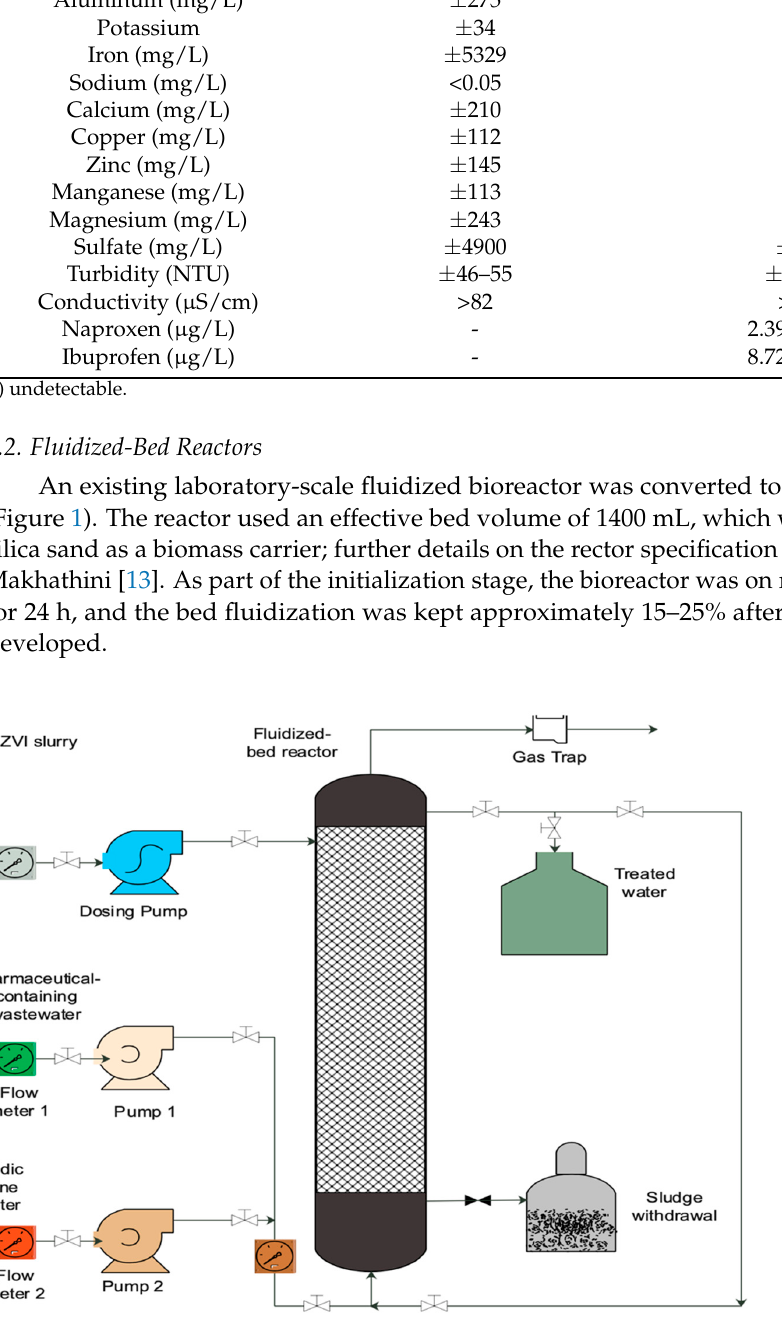
Figure 1. The experimental setup for the fluidized bed reactor.